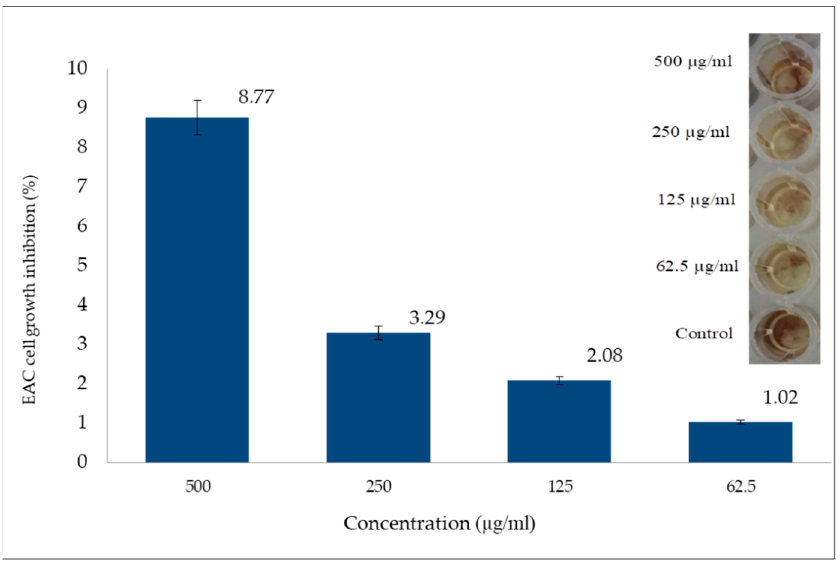
Figure 3. Anticancer screening of compound 9.